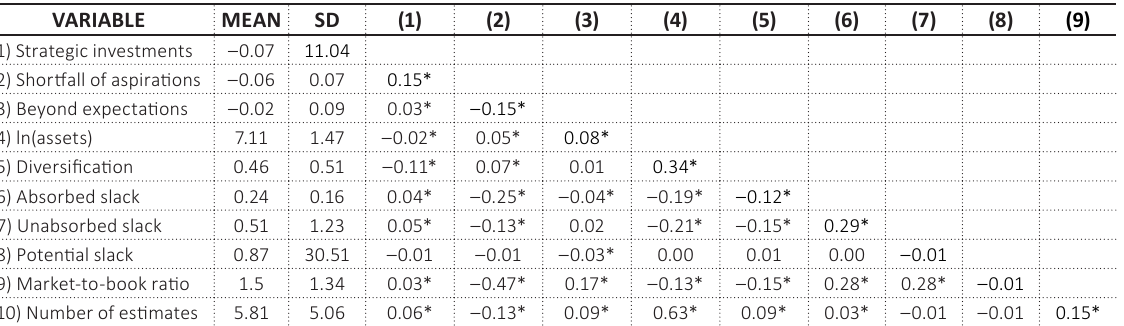
Table 1. Descriptive statistics and pairwise correlations